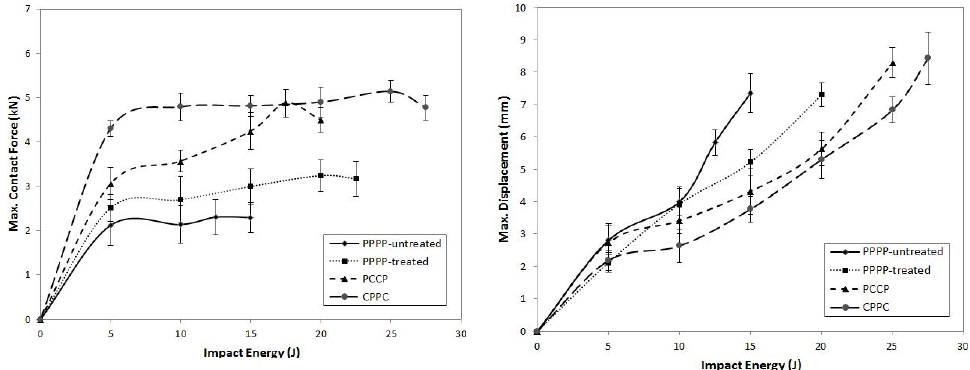
Figure 14. Maximum contact force and displacement against impact energy of the hybrid laminates at ply orientations of [0°/90° 2 , ±45° 2 ] s .